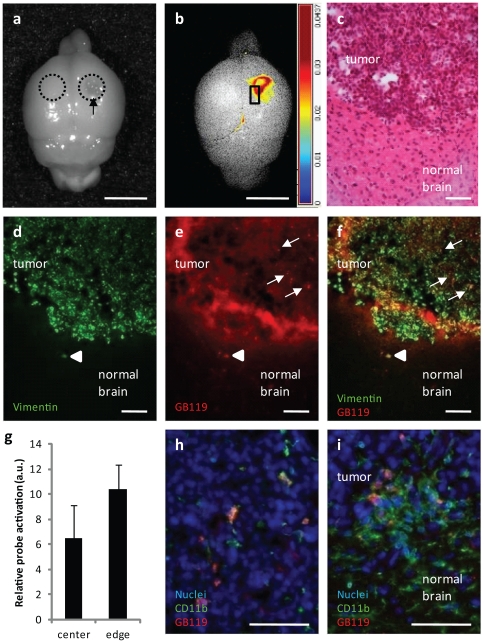
Topical application of GB119 to a brain tumor on the dorsal surface labels the tumor's edge more robustly than the tumor's center.(a) Monochromatic image of a whole brain with a tumor growing near the dorsal surface (arrow) showing the treated areas (outlines). (b) Unmixed false colored map of pixel intensity representing activated GB119 at 35 minutes post application. (c) Horizontal H&E stained section showing higher magnification of square area in panel b demonstrating tumor mass and normal surrounding brain. (d) Adjacent sections revealing human vimentin positive cells labeling tumor edge and center (false colored green), (e) activated GB119 (Cy5, false colored red) revealing infiltrating cells, the tumor margin and to a lesser degree the interior of the tumor and (f) merged imaged demonstrating co-registration (yellow) of GB119-labeled cells and vimentin positive cells within the tumor mass (arrows) and outside of the main tumor mass, arrow head. (g) GB119 labeled cells at the tumor's edge more robustly than at the tumor's center, although not significantly, p = 0.124. (h and i) reveal that GB119 is associated with CD11b-positive cells, but only when they are tumor associated, (h) is a typical image observed from within the tumor interior and (i) shows the images typical of the tumor – brain interface. Note that only CD11b positive cells associated with normal brain do not activate the probe. Section thickness 25 µm (d–f) and 10 µm (h,i). Scale bar, 5 µm (a,b), and 100 µm (c–f, h,i).